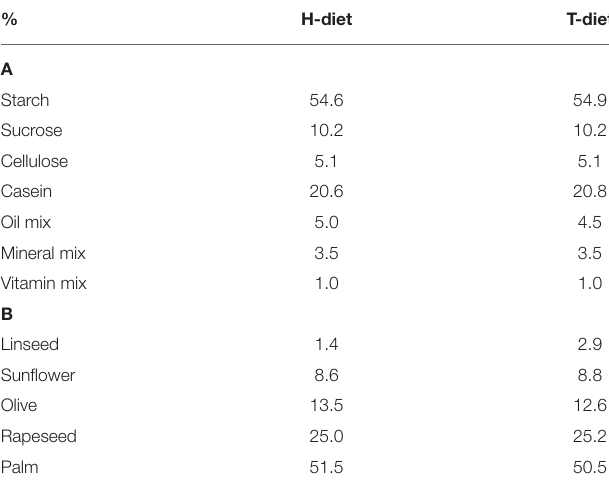
TABLE 1 | The composition of diets (A) and oil mix (B)